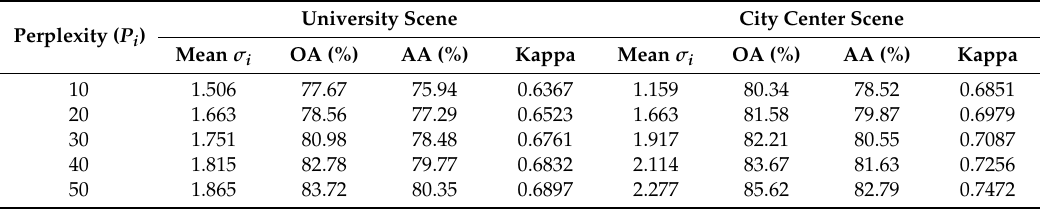
Table 5. Performance evaluation of improved t-SNE with different perplexity for spectral features